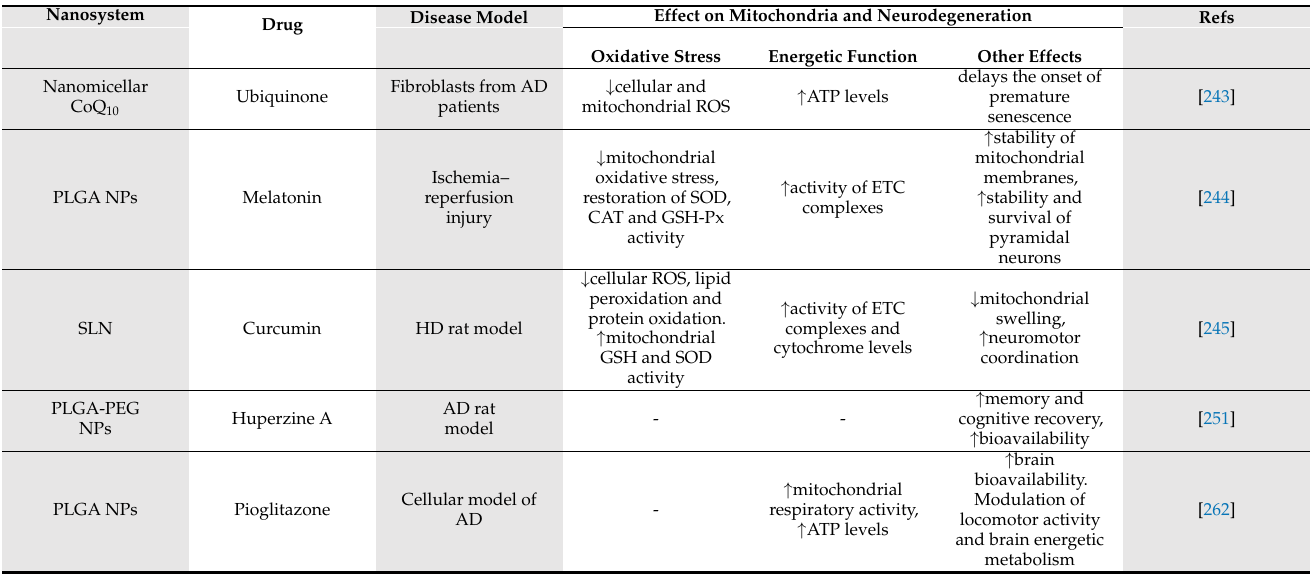
Table 4. Nanosystems containing regulators of mitochondrial energetic function in models of neurodegenerative diseases.